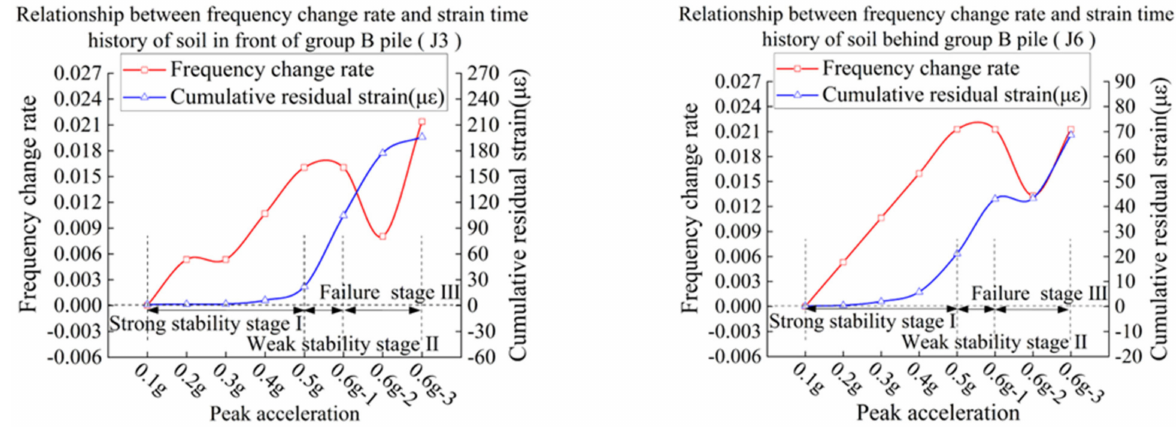
Figure 23. Slope cumulative strain-frequency decline rate curve of model B.